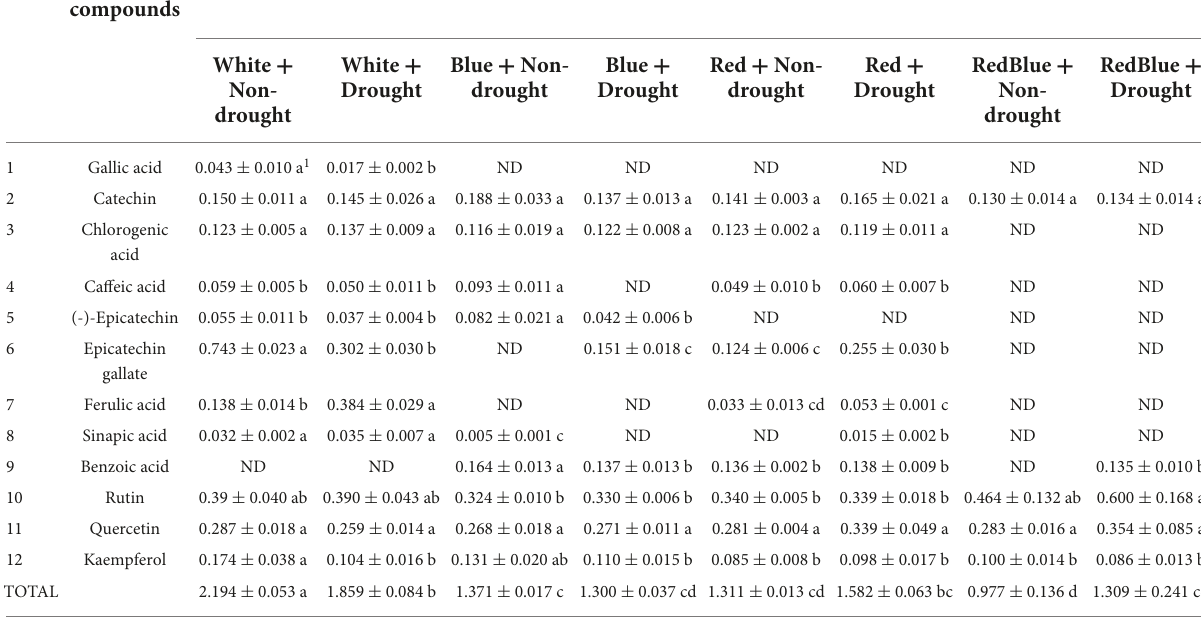
Growing conditions